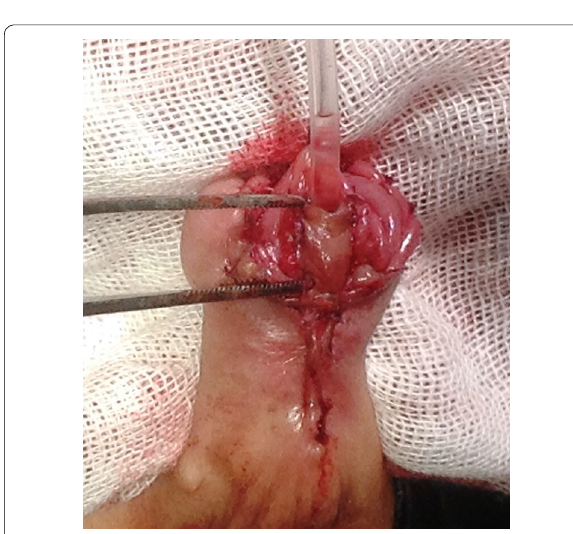
Fig. 5 The remaining part of the flap bridges the defect of the glans penis and prepared to be sutured to the sides of the glans edges